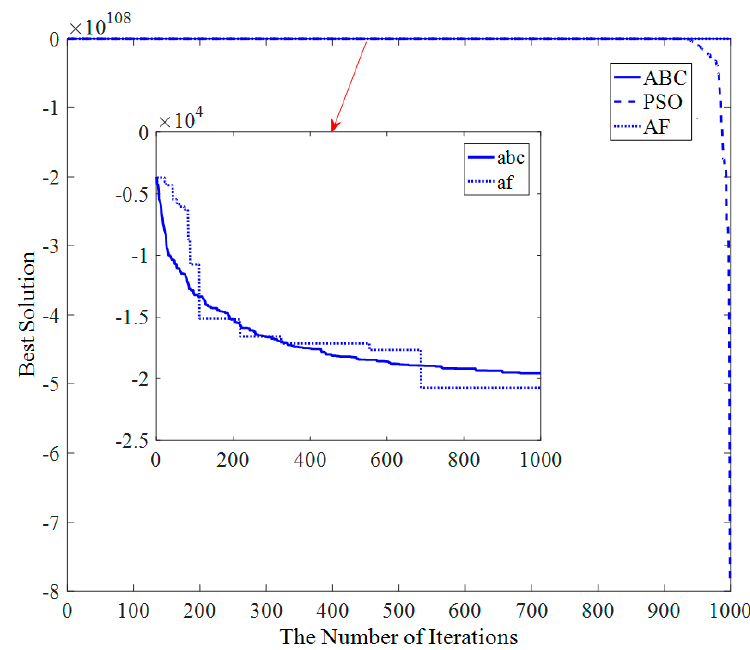
Figure 12. The convergence curve of the three algorithms for Schwefel function in 50-dimensional space.